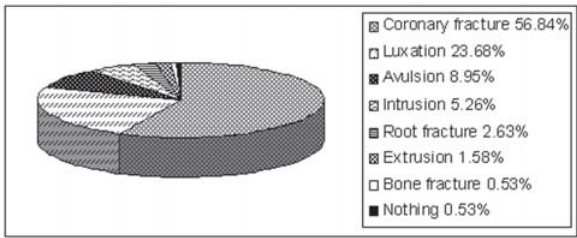
FIGURE 2- Occurrence of different types of traumatic lesions